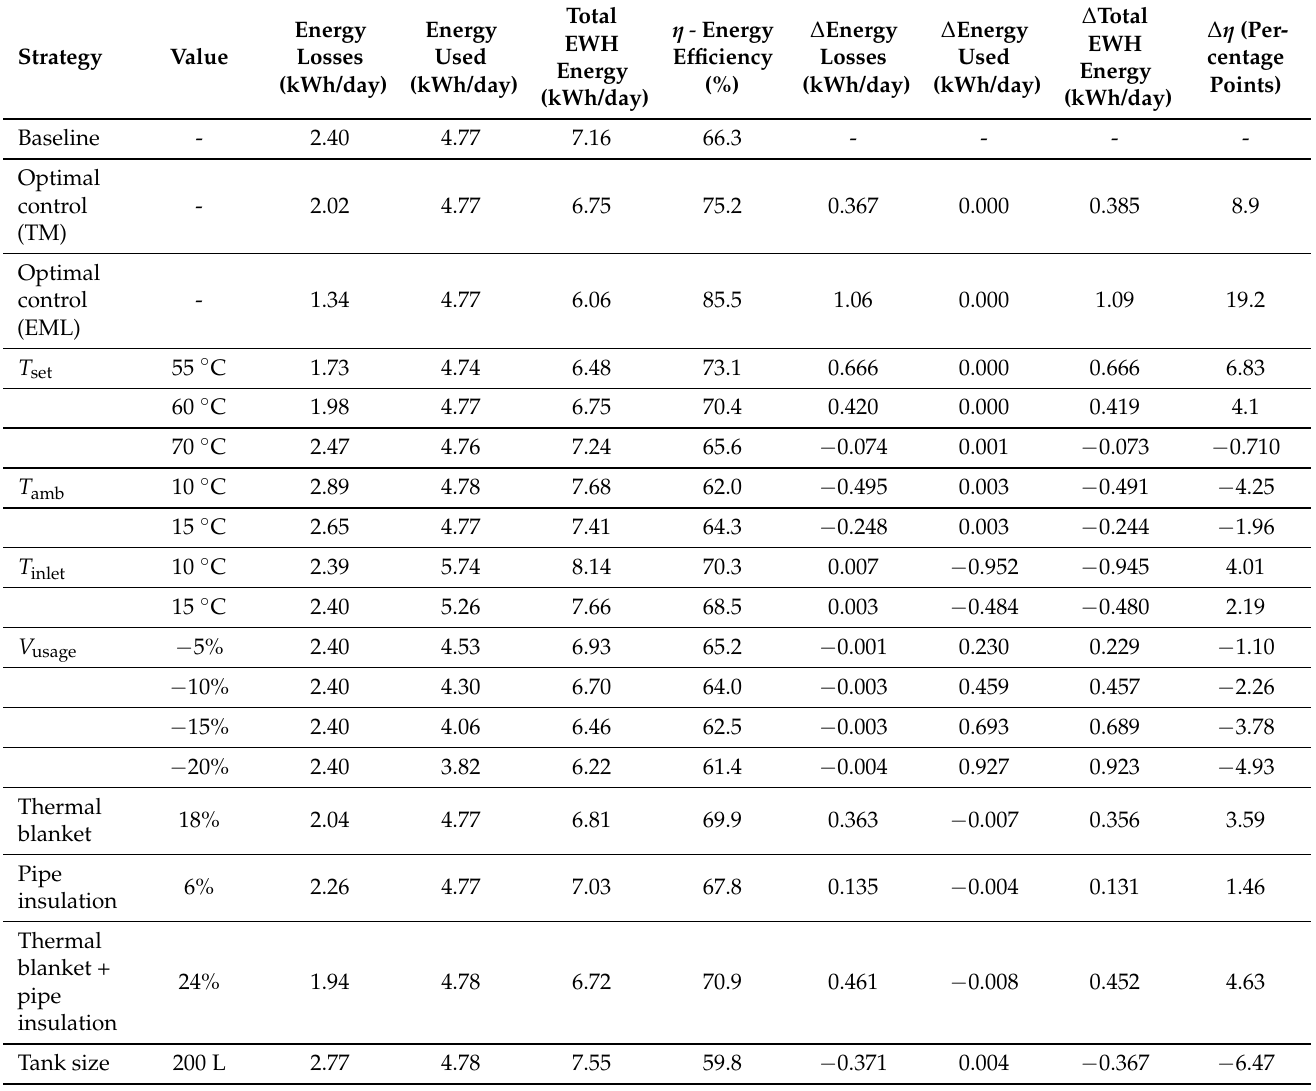
Table 2. Simulation results obtained by the various strategies for 77